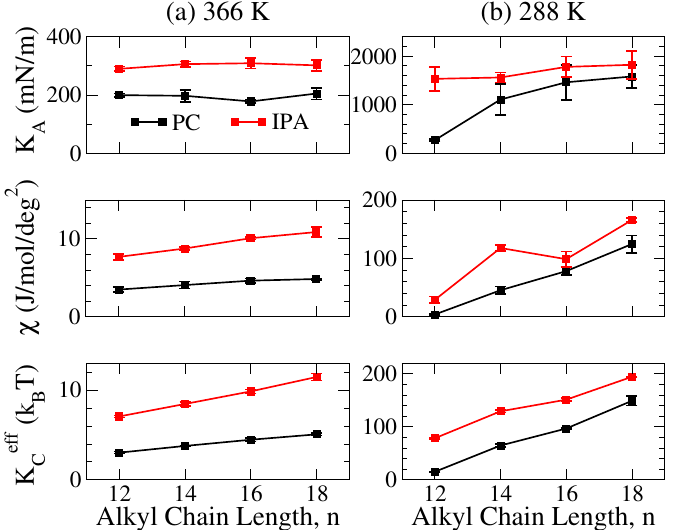
Figure 6. Three mechanical moduli for PC (black) and IPA (red) bilayers with various chain length, n , at ( a ) 366 and ( b ) 288 K: the area compressibility modulus K A (top panel), molecular tilt modulus χ (middle panel), and effective bending rigidity K ef f (bottom panel). The standard deviations were C evaluated from three independent MD